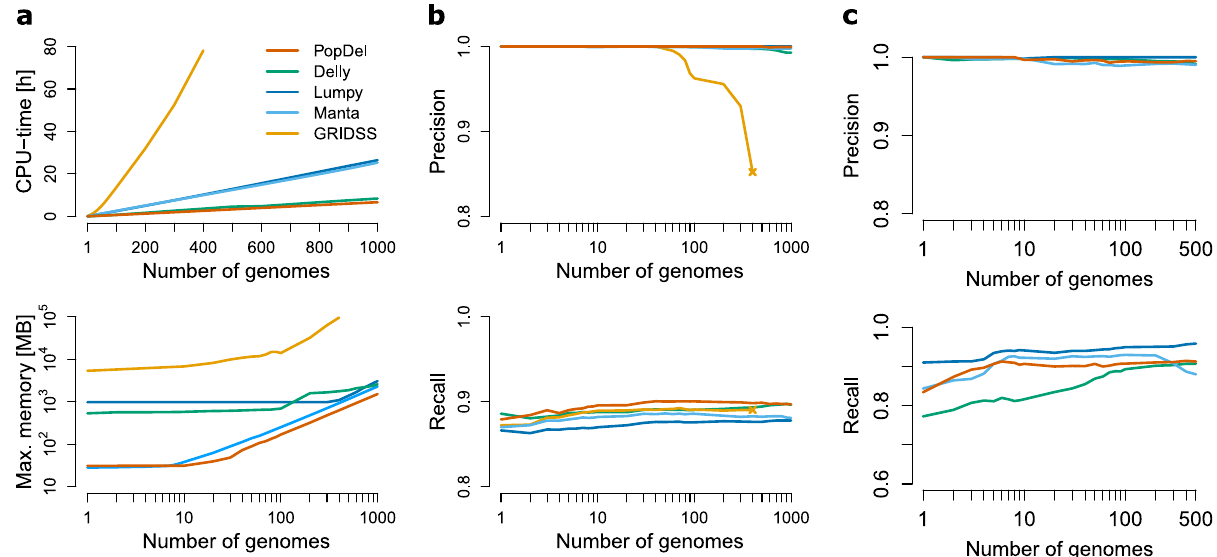
Fig. 2 Performance of our approach on simulated data. We compared PopDel to Delly, Lumpy (via Smoove), Manta, and GRIDSS for increasing numbers of genomes. a Running time and memory on data with deletions randomly placed on human chromosome 21. b Recall and precision on data with random deletions. c Recall and precision with deletions reported by the 1000 genomes project simulated on chromosomes 17 –